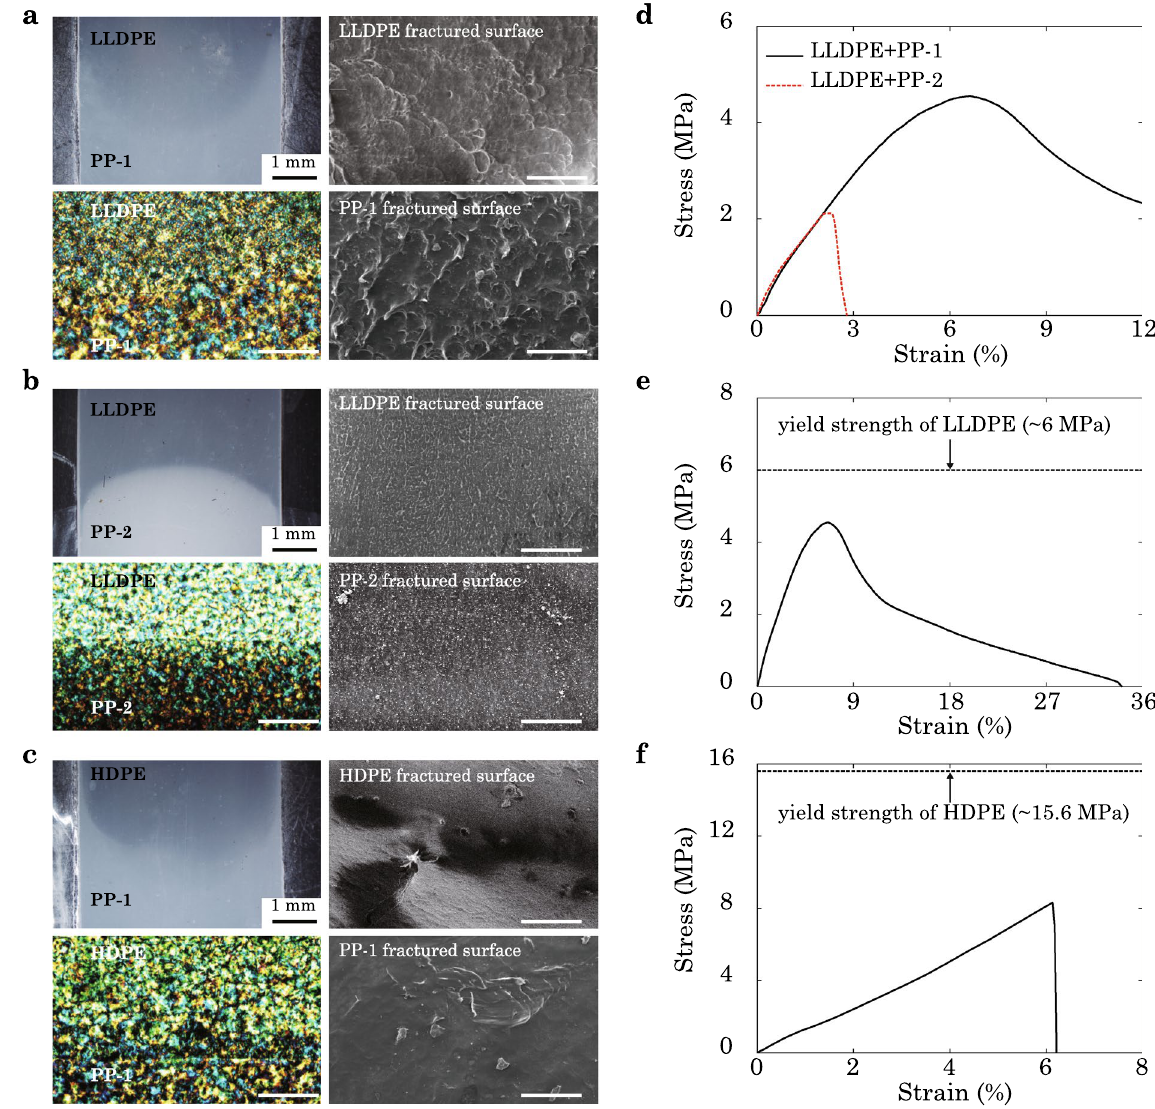
Figure 6. Experimental characterization of ( a ) LLDPE/PP-1, ( b ) LLDPE/PP-2, and ( c ) HDPE/PP-1 interfaces, where the left top panel is obtained from optical microscope (OM), the left bottom is from polarized light microscope (PLM), and the right two panels are from scanning electron microscopy (SEM). The unlabelled scale bars are 100 µm. ( d – f ) Experimental results of the typical stress–strain curves of LLDPE/PP-1 and LLDPE/PP-2 ( d ), LLDPE/PP-1 ( e ) and HDPE/PP-1 ( f ) samples fabricated by HCM. All the samples are fused for 1